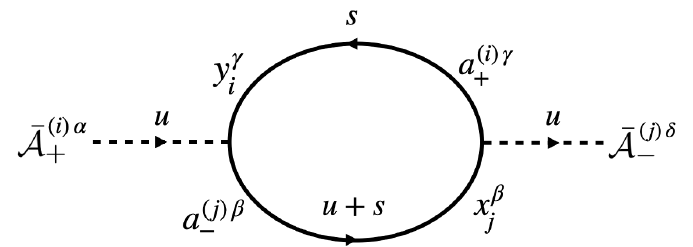
Figure 6 . The only class of divergent diagrams contributing to the 1-loop effective action (4.5) for theories with Lax connection of the form (4.1). These diagrams are summed over the indices i, j labelling the external background